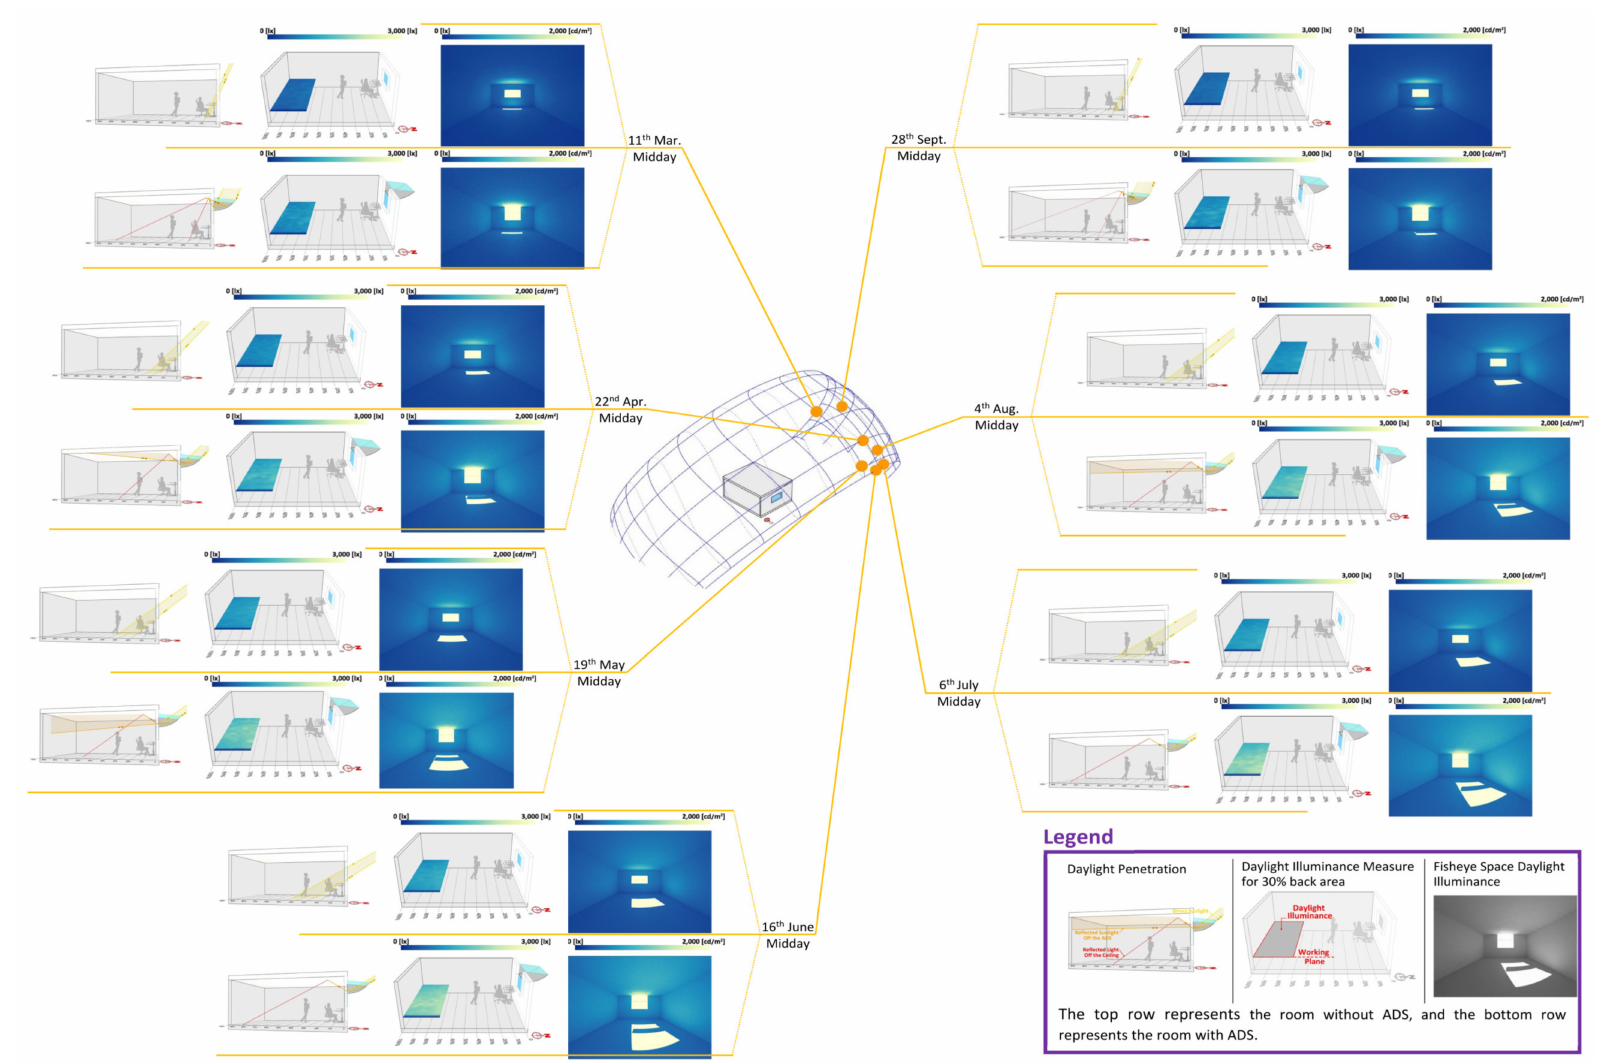
Figure 15. A careful comparison of the ADS’ effectiveness in diffusing sunlight towards the back of the